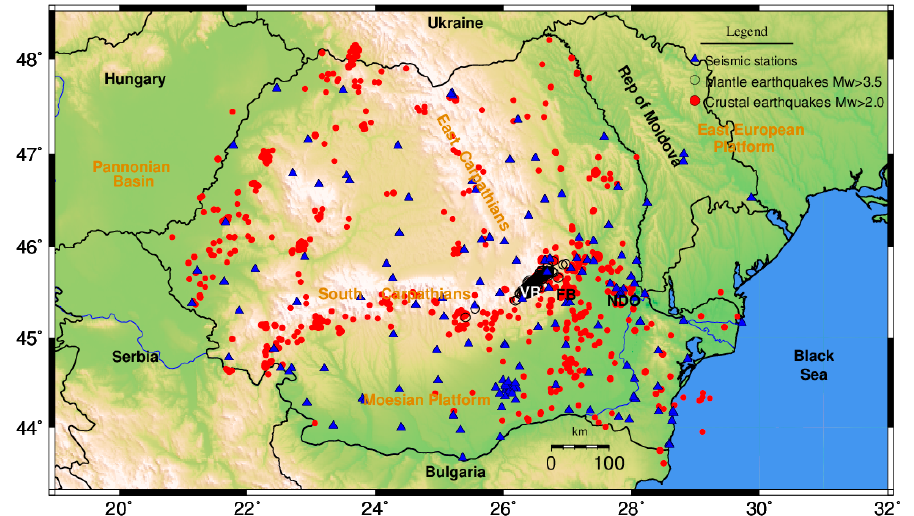
Figure 1. Distribution of seismic stations and epicenters associated with crustal (Mw > 2.0) and intermediate depth (Mw > 3.5) earthquakes, selected from the ROMPLUS catalogue [18] between January 2015 and October 2020. The main tectonic features are also displayed. The abbreviations are as follows: VR—Vrancea region, FB—Focsani Basin., NDO—North Dobrogean Orogen.